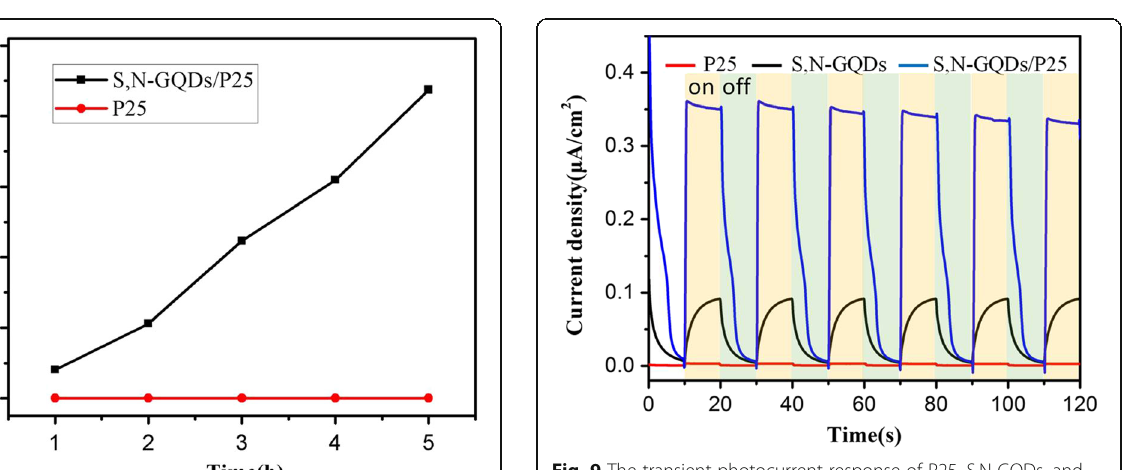
Fig. 9 The transient photocurrent response of P25, S,N-GQDs, and S,N-GQD/P25 composites under UV – vis light